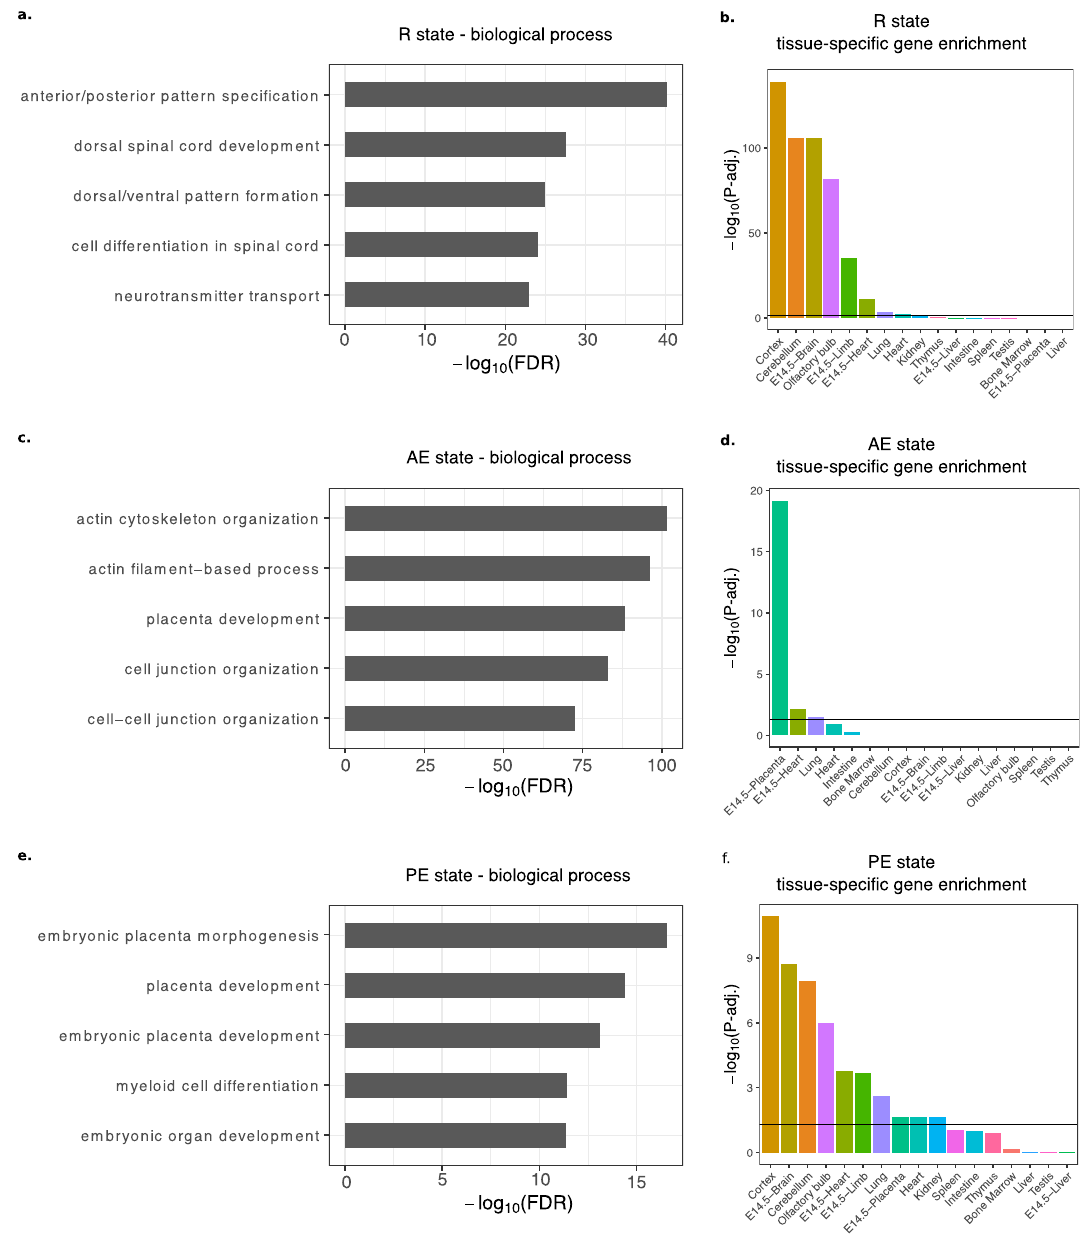
Figure 3. Repressed regions are associated with neuronal terms while enhancers are associated with placental development. ( a ) Genes associated with repressed regions are enriched for biological processes related to spinal cord development and pattern formation. ( b ) Genes associated with the R state are enriched for genes with brain-specific expression (cortex, e14.5 brain, cerebellum, and olfactory bulb). ( c ) Genes associated with active enhancers are enriched for biological processes related to placental development and cytoskeleton organization. ( d ) Genes associated with the AE state are strongly enriched for genes with placenta-specific expression. ( e ) Genes associated with poised enhancers are enriched for biological processes related to placental development. ( f ) Genes associated with the PE state are enriched for genes with tissue-specific expression in multiple that associated H3K27me3 activity with neuronal genes in the e9.5 placenta 47 . Genes associated with regions in the AE and PE states are associated with placental development (Fig. 3c,e), however, those associated with active enhancers are enriched for actin cytoskeleton and cell junction organization (Fig. 3c) as well, processes impor- tant for trophoblast cell differentiation and cellular adhesion 52,53 . When using the Mouse Phenotype Single KO ontology, we observe enrichment of several terms related to placenta morphology (abnormal placenta morphol- ogy, abnormal trophoblast layer morphology, and abnormal placenta labyrinth morphology) and embryonic lethality (embryonic lethality prior to organogenesis) associated with the AE state genes, whereas such placenta terms were not enriched for PE state genes (Supplementary Figure S3). AE genes, such as Cdkn1c , Il11ra1 , Rbpj , Birc6 , and Ncoa6 all play important roles in placental development and morphology, which has been shown